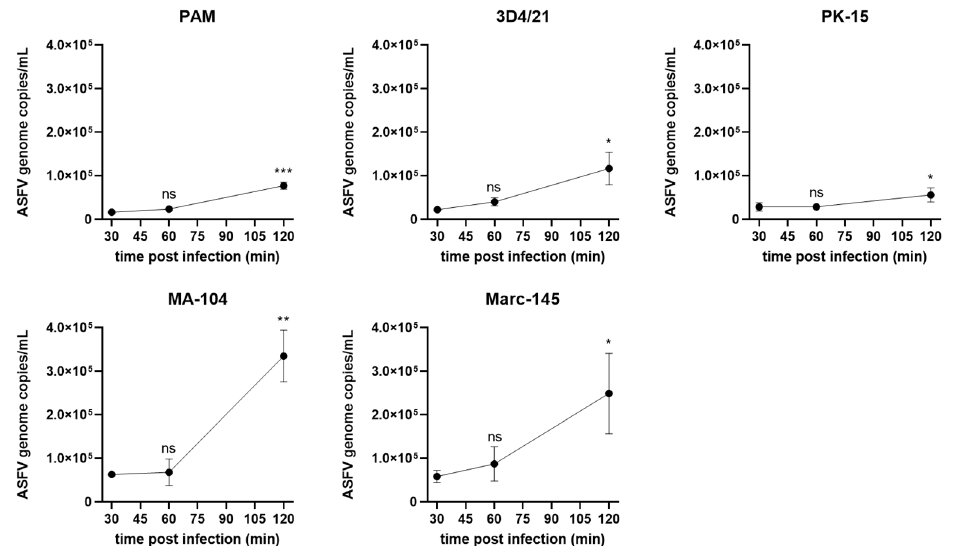
Figure 3. ASFV genomic DNA quantification after entry into PAMs, 3D4/21, PK − 15, MA − 104 and Marc-145 cells. The cells were infected with ASFV at 5 MOI and incubated for 1 h at 4 ◦ C. After washing with PBS 3 times and incubation for 30 min, 1 h and 2 h at 37 ◦ C, ASFV genomic DNA was quantified with real-time PCR with primers targeting B646L gene. Results are presented as the mean ± SD of data from three independent experiments; ns, not significant; *, p < 0.05; **, p < 0.01, ***, p < 0.005.